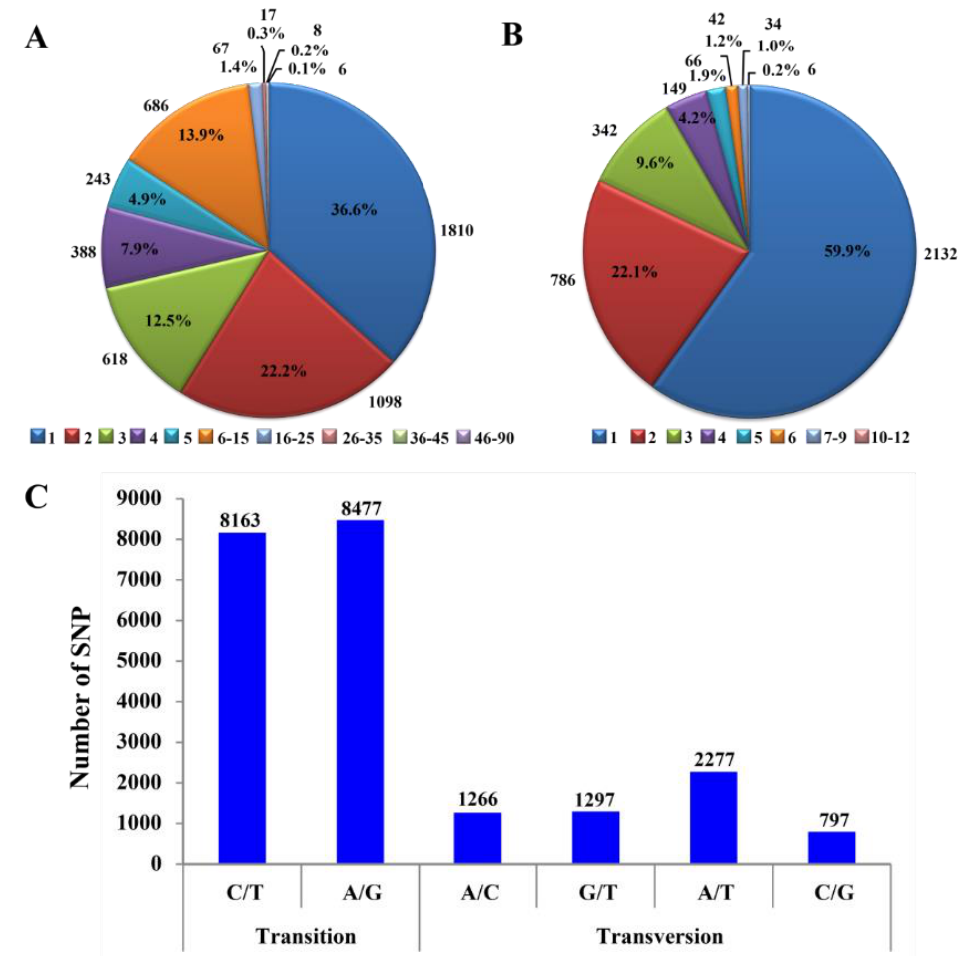
Figure 2. Characterization of single-nucleotide polymorphism (SNP) and insertion and deletion (InDel) markers: ( A ) number of SNPs in a single unigene; ( B ) number of InDels in a single unigene, and ( C ) classification of SNPs including number of SNPs.